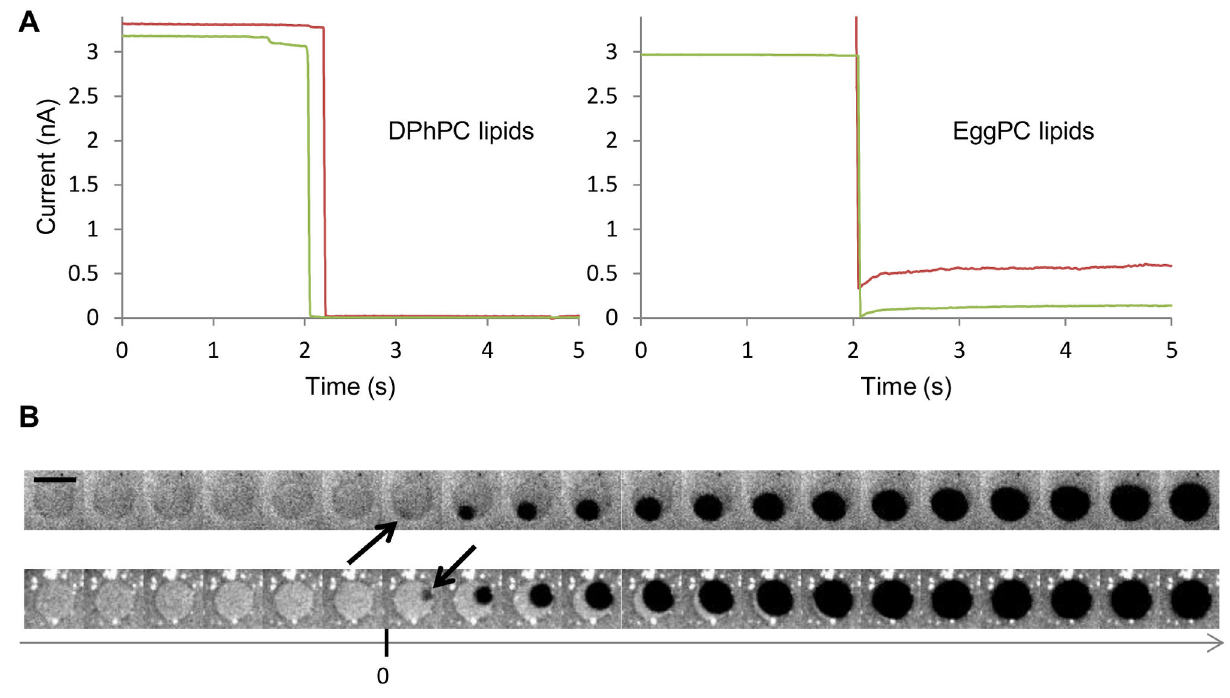
Figure 4. Capillary patch clamp stability. A\ Traces of ionic current during the formation of a membrane patch from DPhPC GUVs (left) and from EggPC GUVs (right). Gigaseals are obtained only for DPhPC lipids. B\ Time lapse images centered on the ID region of the capillary, showing two examples of DPhPC membrane patch breakage. For t < 0, the membrane patch is intact and visible thanks to fluorescently labeled membrane. At t = 0, holes are nucleated at the contact circle between the supported and free standing membrane region. At t > 0, the nucleated holes expand progressively until they uncover the totality of the capillary ID. Images are separated by 0.1 s. Scale bar: 10